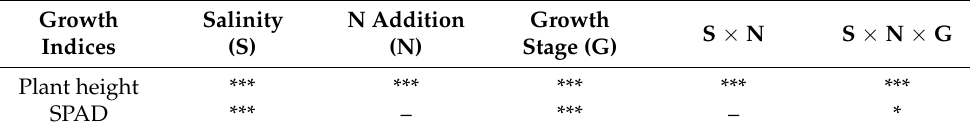
The multiple-way ANOVA analysis results are also shown for indicating the significance of main and interaction effects: ***, p < 0.001; *, p < 0.05; –, not significant. Table 5. Mean values and results of multiple-way ANOVA on the effects of salinity (S), N addition (N), and their interactions (S × N) on aboveground biomass and other growth indices of P. australis . Treatments